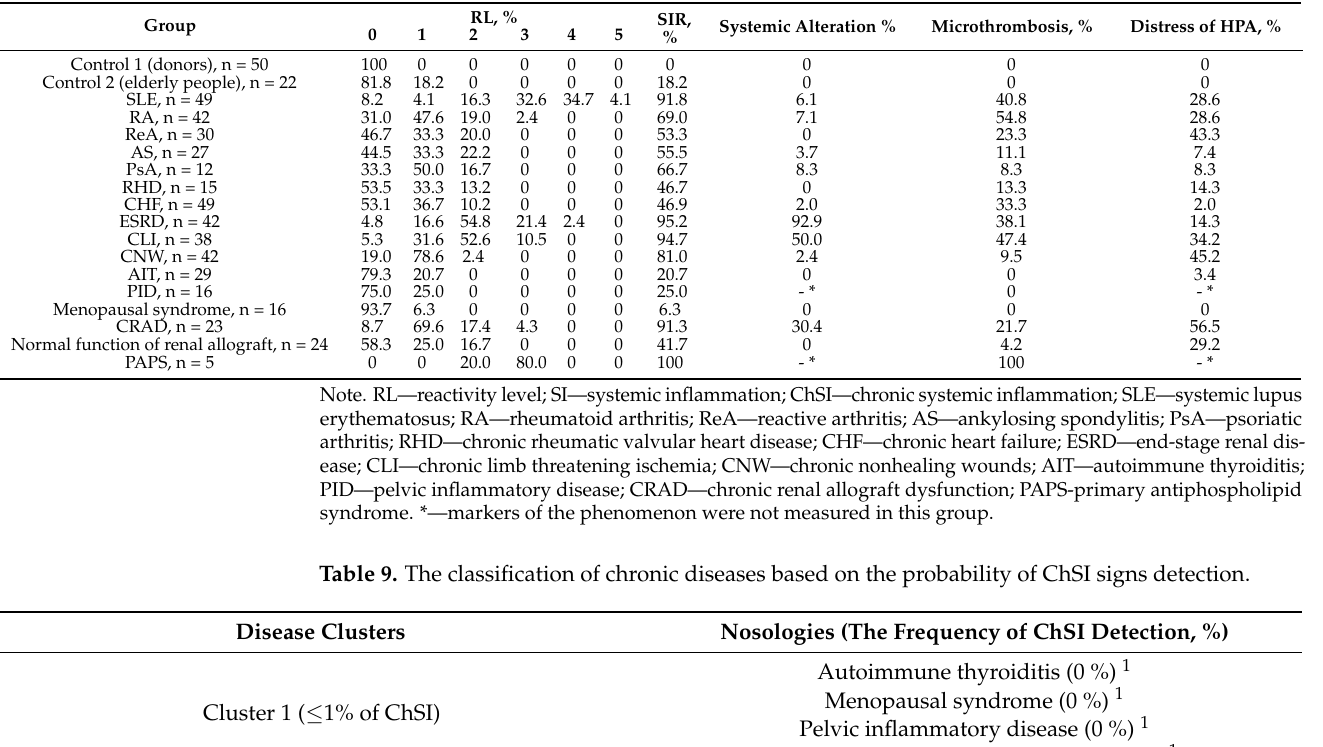
Table 8. Frequency of RL values and basic ChSI phenomena in groups of patients with chronic nosologies.